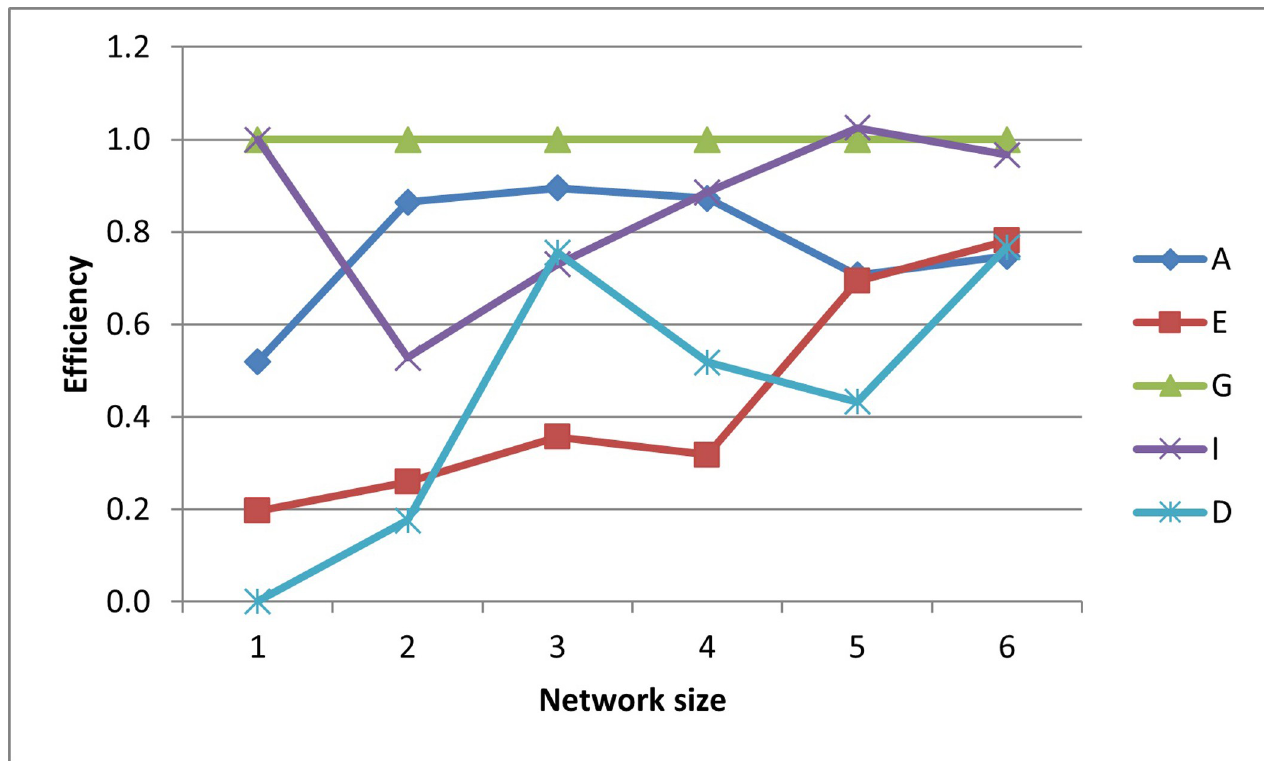
Fig 9. G-efficiencies of various optimal designs for the first case study.